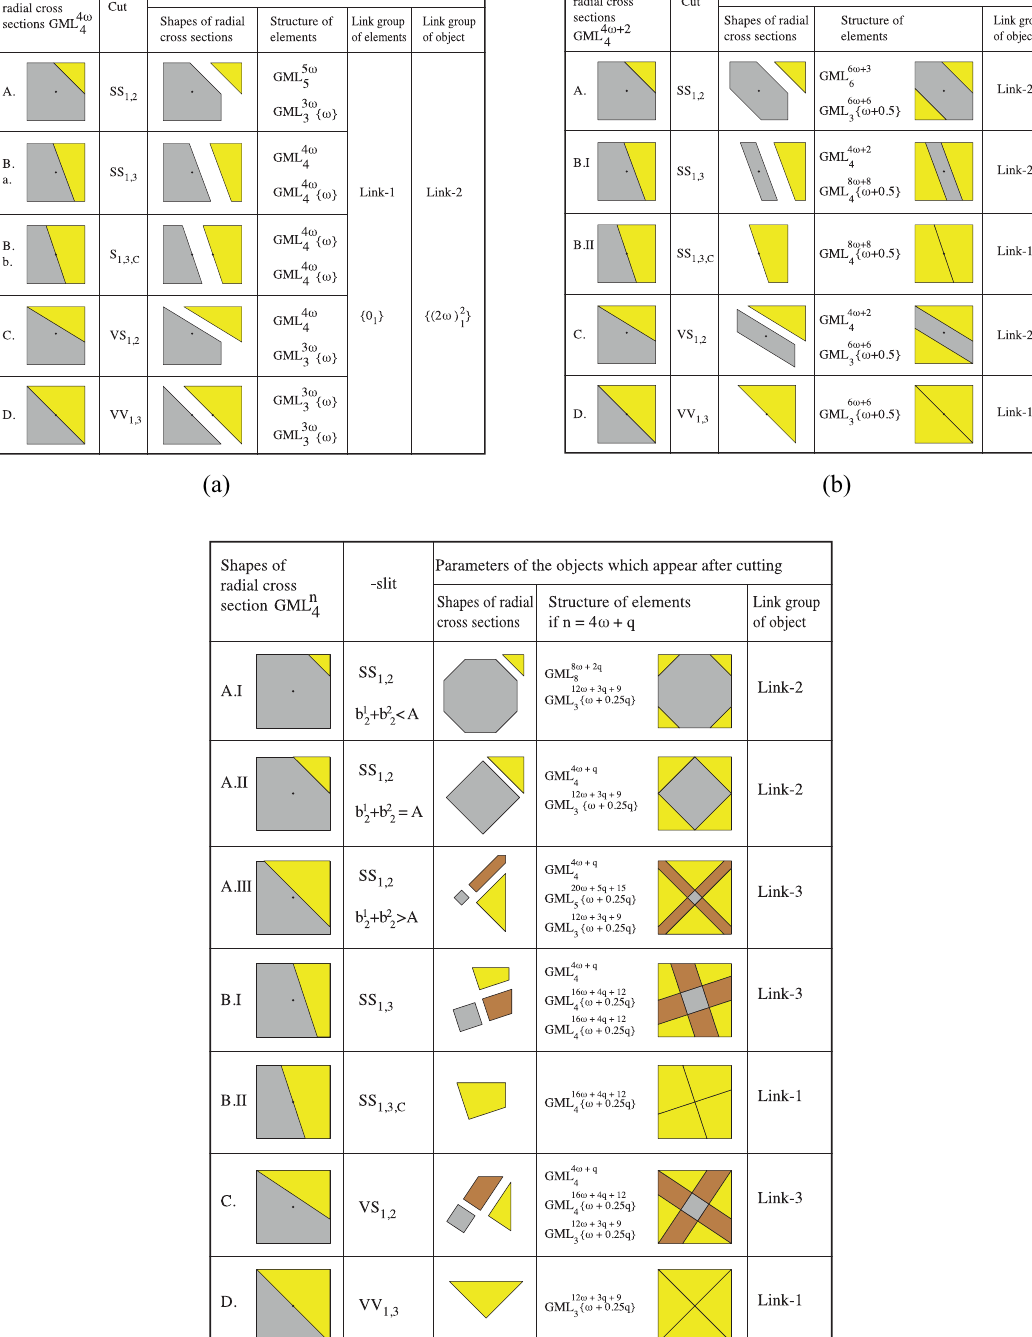
, (b) GML 4 x þ 2 ( x = 0, 1, 2, ... ), (c) GML n , with resulting number, shape and twisting of resulting 4 4 4